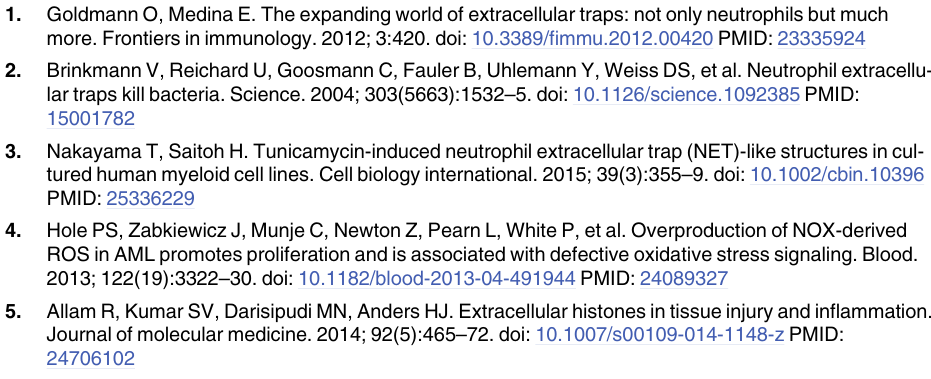
S2 Fig. Effects of histone inhibitors on histone-inducedendothelialadhesion molecule